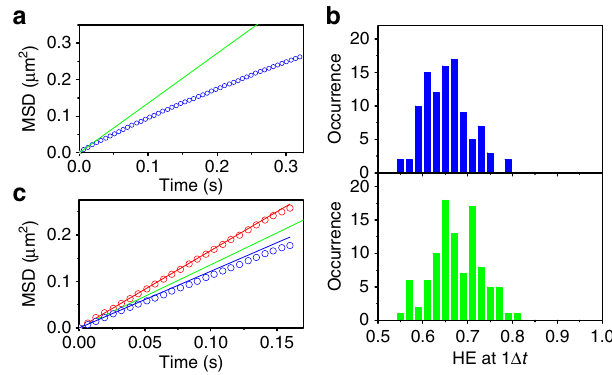
Figure 10 | Lattice occupancy analysis of lambda DNA. ( a ) MSD- D t profile of lambda DNA ( D t ¼ 6.4ms). The red line shows the theoretical MSD- D t profile. ( b ) Frequency histogram of the HE-1 D t distribution of the experimental (top) and the S r A r simulated replicates (bottom) of lambda DNA. ( c ) Averaged MSD- D t profiles of the sub-trajectories captured in the same way as in Fig. 7a (red) and Fig. 7b (blue). The red and blue lines are the theoretical MSD- D t profiles. The green line shows the overall, theoretical MSD- D t profile of the experimental